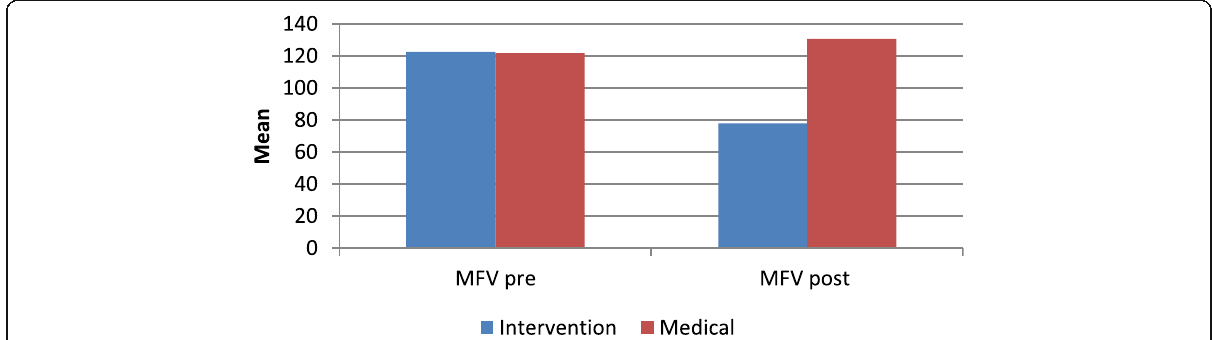
Fig. 3 TCD MFV of interventional and medical groups pre-intervention and 3 months post